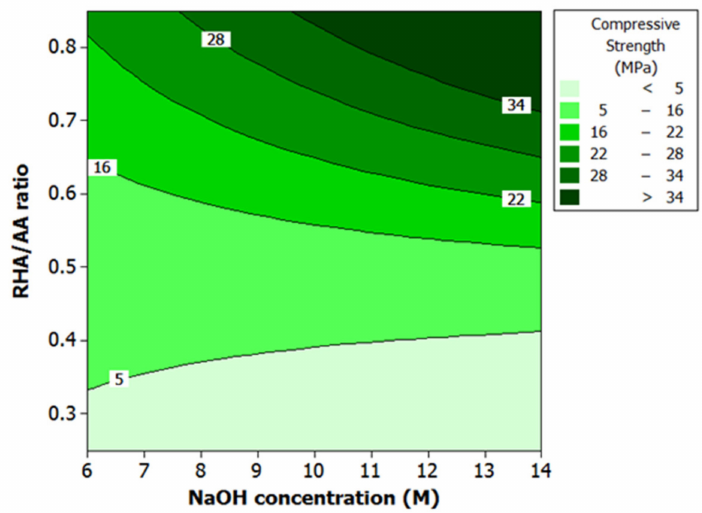
Figure 5. Contour plot for the effect of RHA/AA ratio and NaOH concentration on the compressive strength.